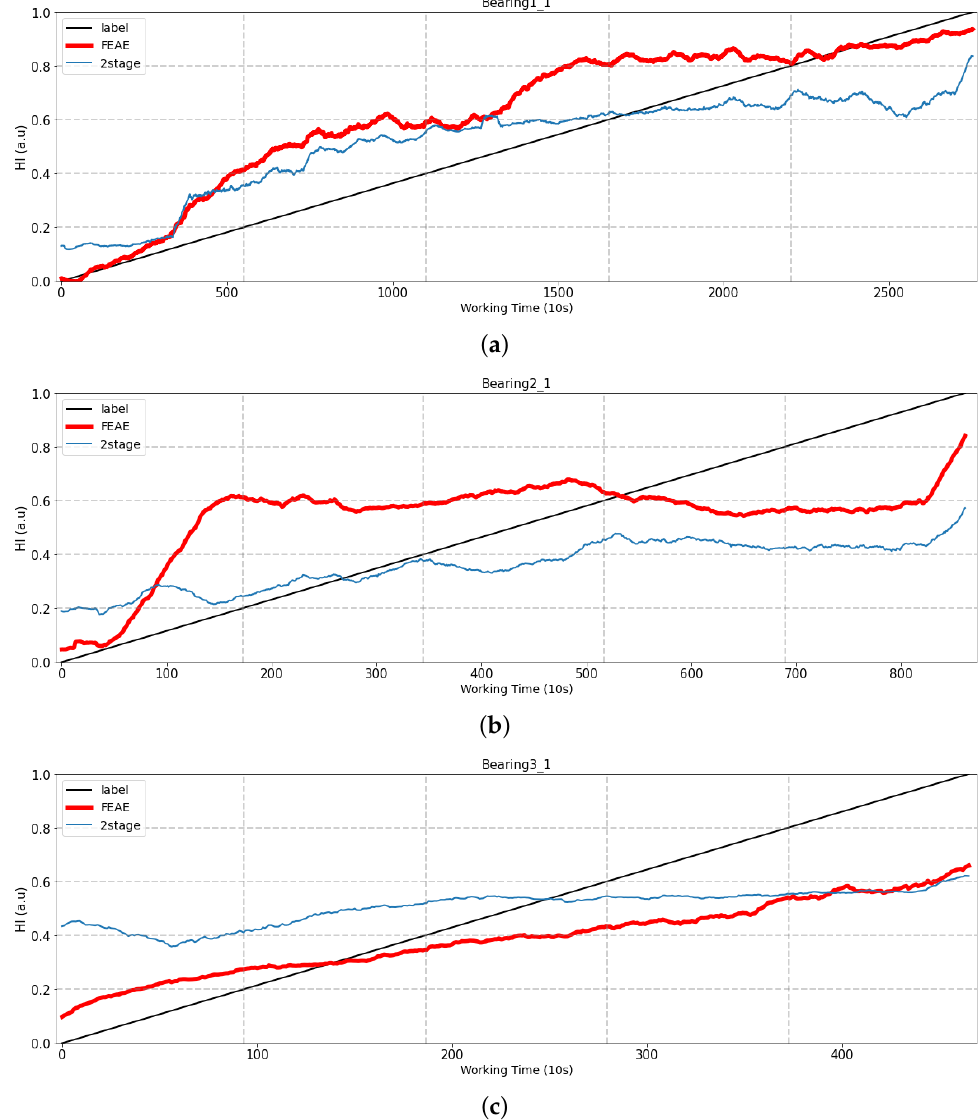
Figure 14. Comparison of experiment results of multi-/single-stage models. ( a ) Test bearing1_1, ( b ) Test bearing2_1, ( c ) Test